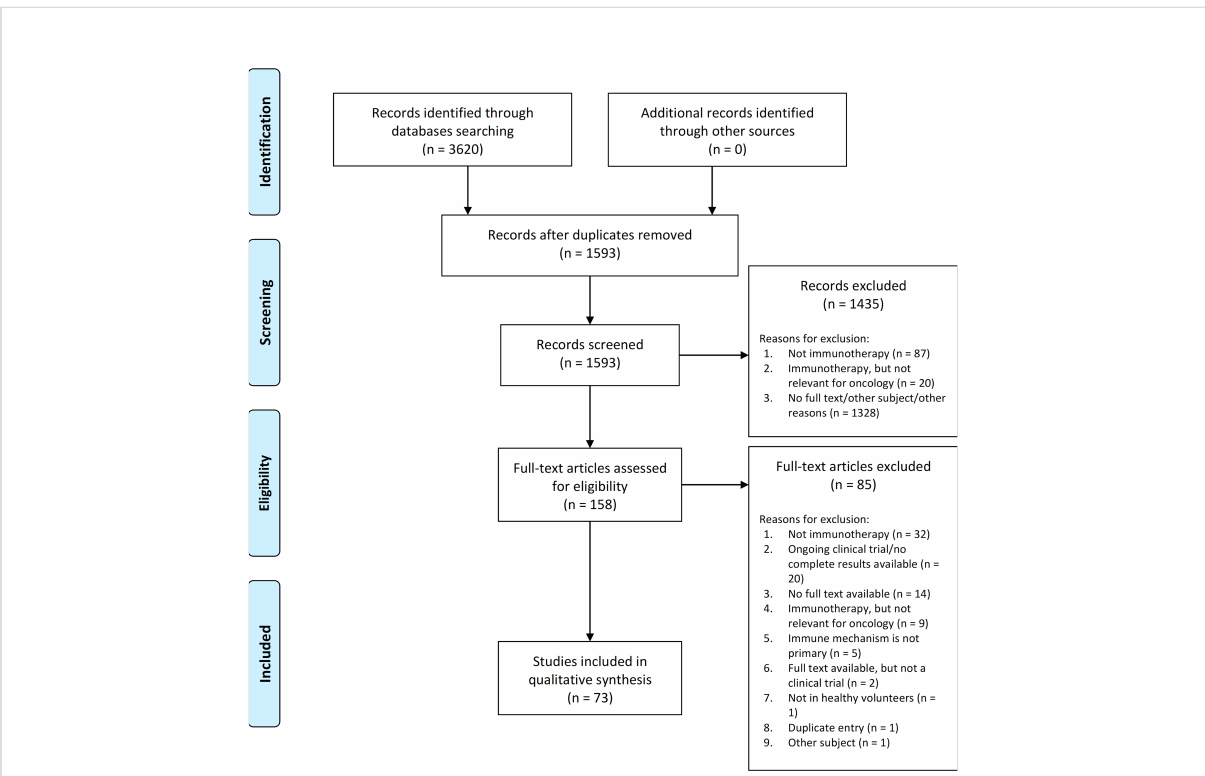
FIGURE 1 PRISMA diagram showing the total number of studies found by the search, screened, excluded (with reasons for exclusion at screening and full- text review) and